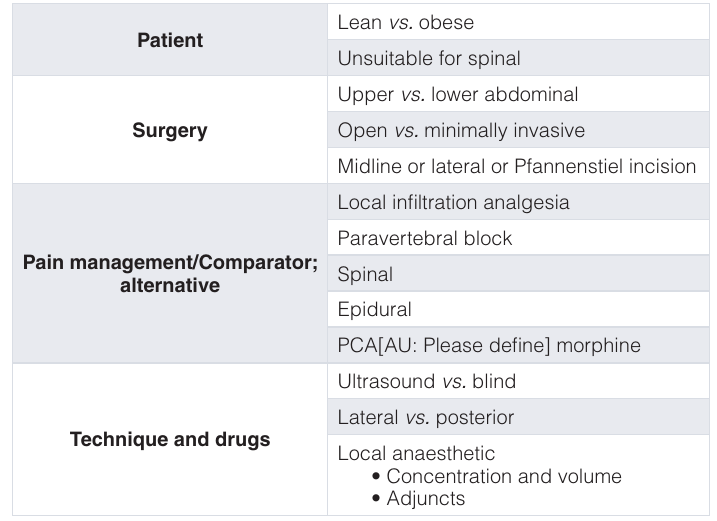
Table 2. Considerations around